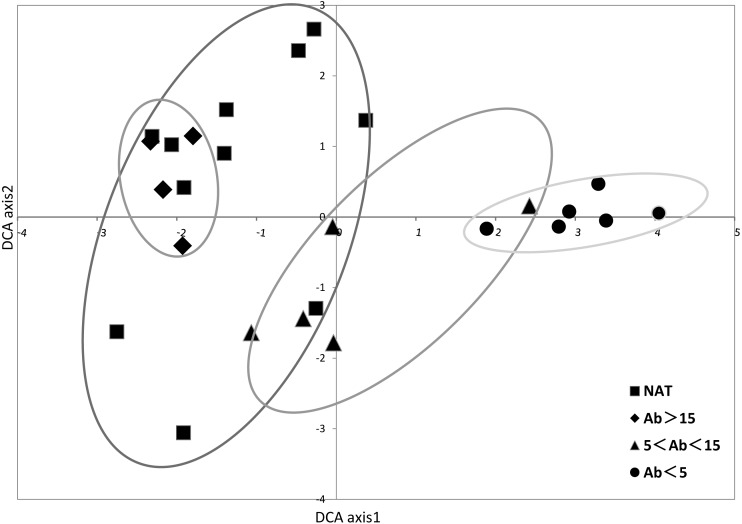
DCA ordination of species percentage cover showing samples.Axes 1 and 2 accounted for 0.8687 and 0.7182, respectively, of total variation in data. Ellipses were drawn to group the samples by abandoned ages in paddy fields and reference natural wetland.